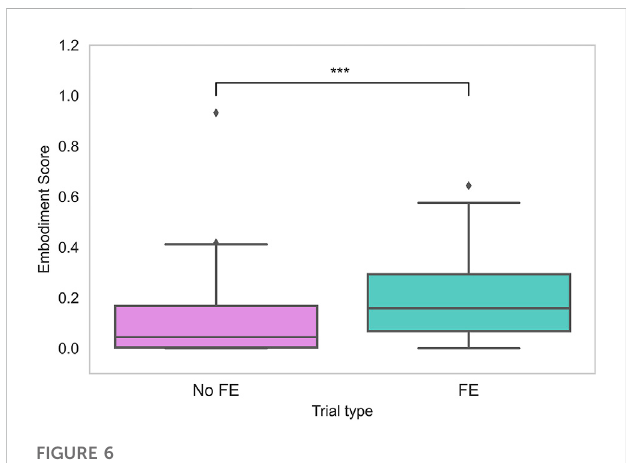
FIGURE 6 Sense of embodiment scores depending on the occurrence of the follower